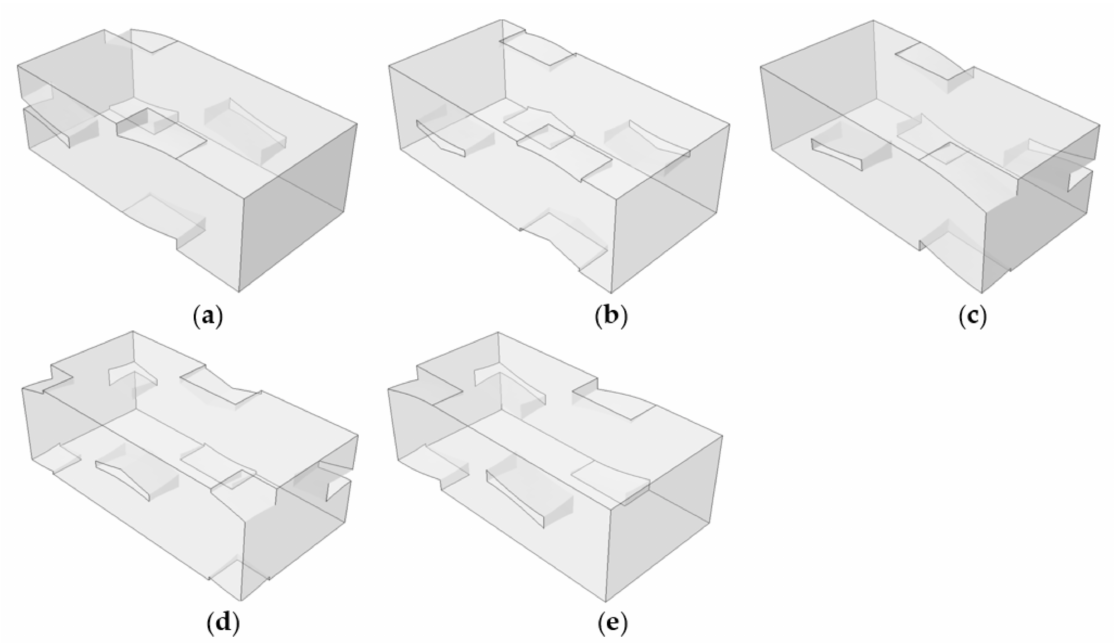
Figure 24. Definition of void defects for two-ply shifted plain weave unit cell: ( a ) MPV21; ( b ) MPV22; ( c ) MPV23; ( d ) MPV24; and ( e )